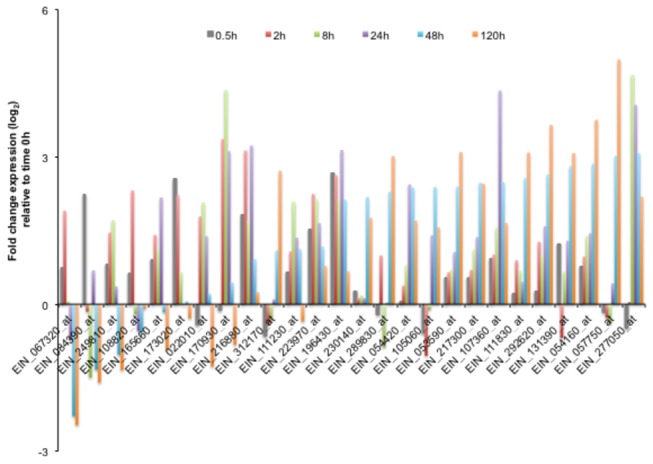
Modulation of the transcript level of the

E

. invadens
 BspA- like genes during encystation.Values are expressed as log2 fold change of expression relative to time 0 h.